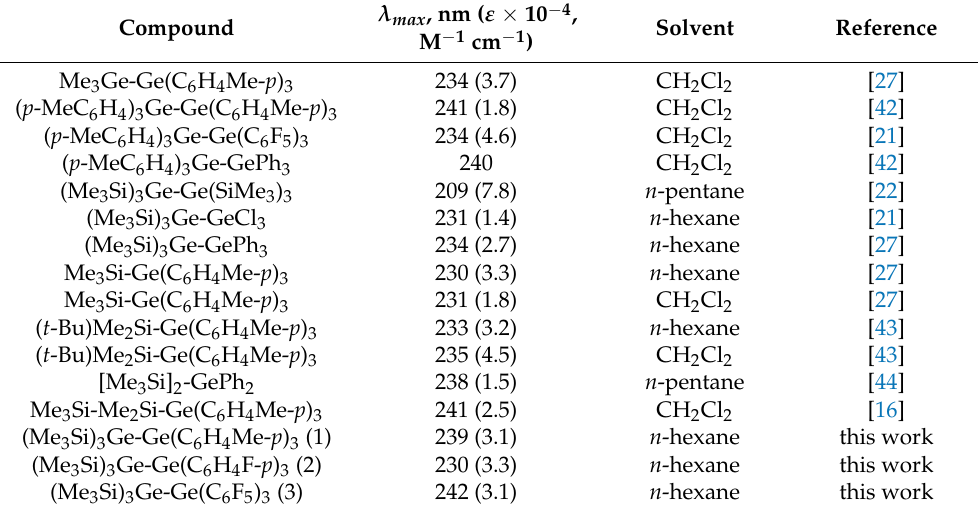
Table 2. Comparison of absorption maxima in UV/visible spectra for 1 – 3 and related compounds. Compound